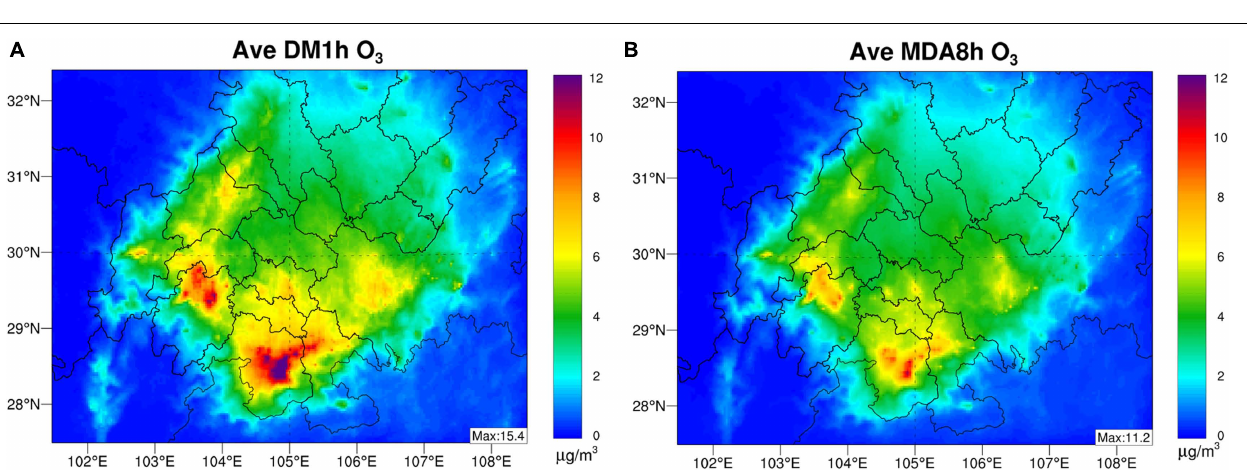
FIGURE 7 | Contribution of BVOC emissions on monthly average daily maximum hourly O 3 concentrations (DM1h O 3 ) and daily maximum 8-h average (MDA8) O 3 concentrations in July 2017.